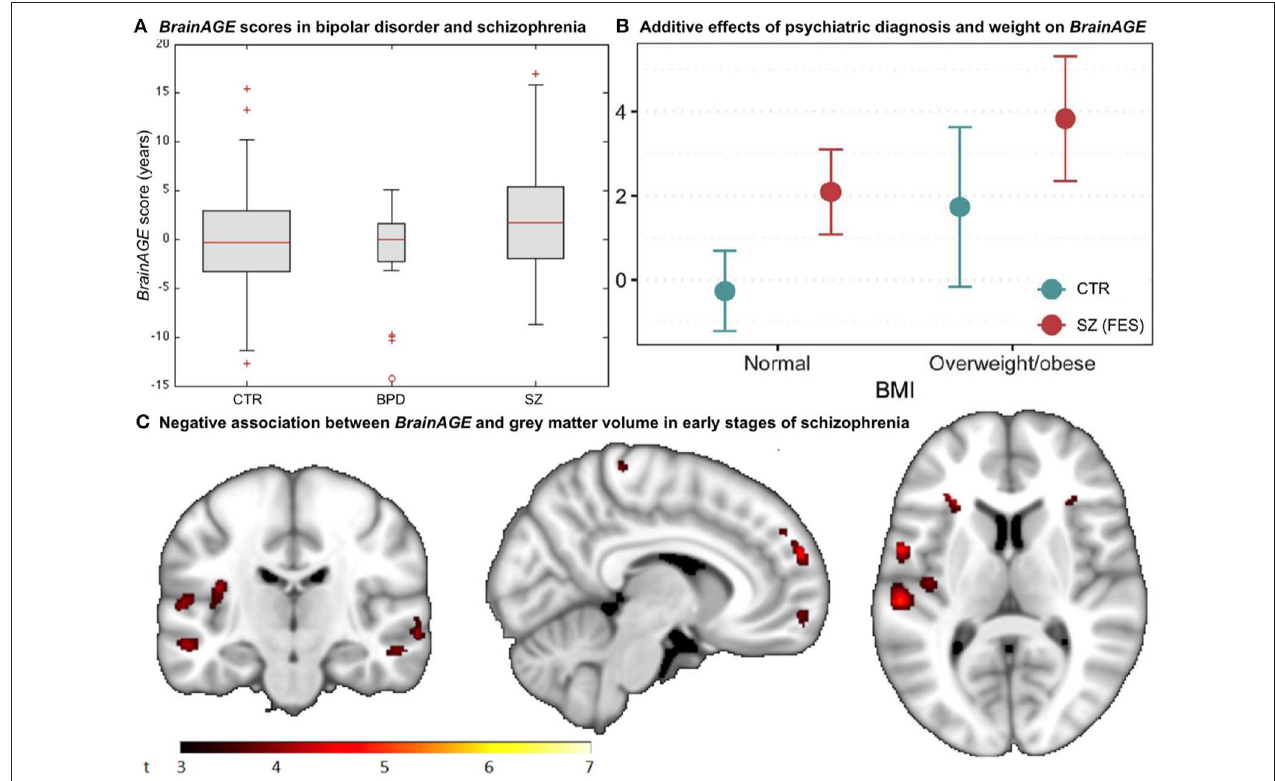
FIGURE 8 | BrainAGE in psychiatric disorders. (A) Box-plot of BrainAGE scores in healthy controls (CTR), bipolar disorder patients (BPD), and schizophrenia patients (SZ) with significant group effect (ANOVA, p = 0.009), and schizophrenia patients showing higher BrainAGE scores than either CTR or BPD. [Figure and legend reproduced from Nenadic et al. (38), with permission from Elsevier, Amsterdam.] (B) Associations between BrainAGE scores and psychiatric diagnosis and metabolic factors. Obesity was significantly associated with BrainAGE scores additively to the effect of first-episode schizophrenia (FES; age adjusted mean and 95% confidence intervals). [Figure and legend reproduced from Kolenic et al. ( 40), with permission from Elsevier, Amsterdam.] (C) Negative association between BrainAGE and gray matter volume in participants with first episodes of schizophrenia-spectrum disorders ( P ≤ 0.001, cluster extent = 50). [Figure and legend from Hajek et al. ( 39), with permission from Oxford University